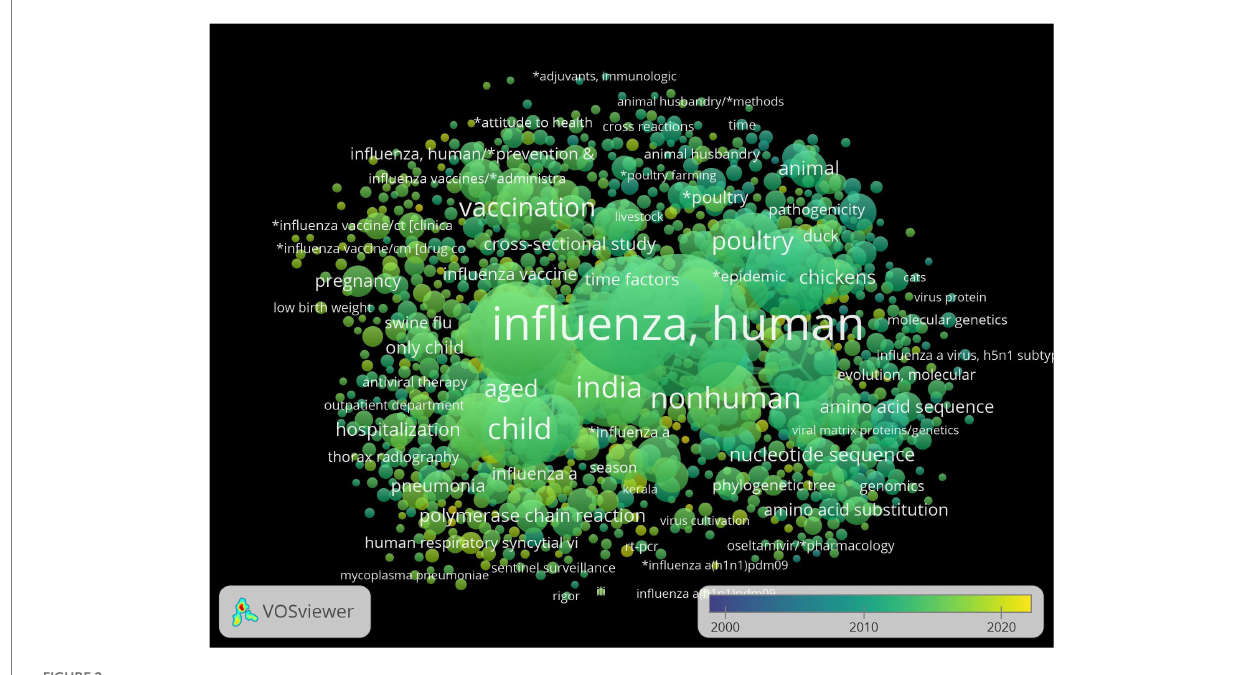
FIGURE 2 Overlay visualization of co-occurrence of keywords.